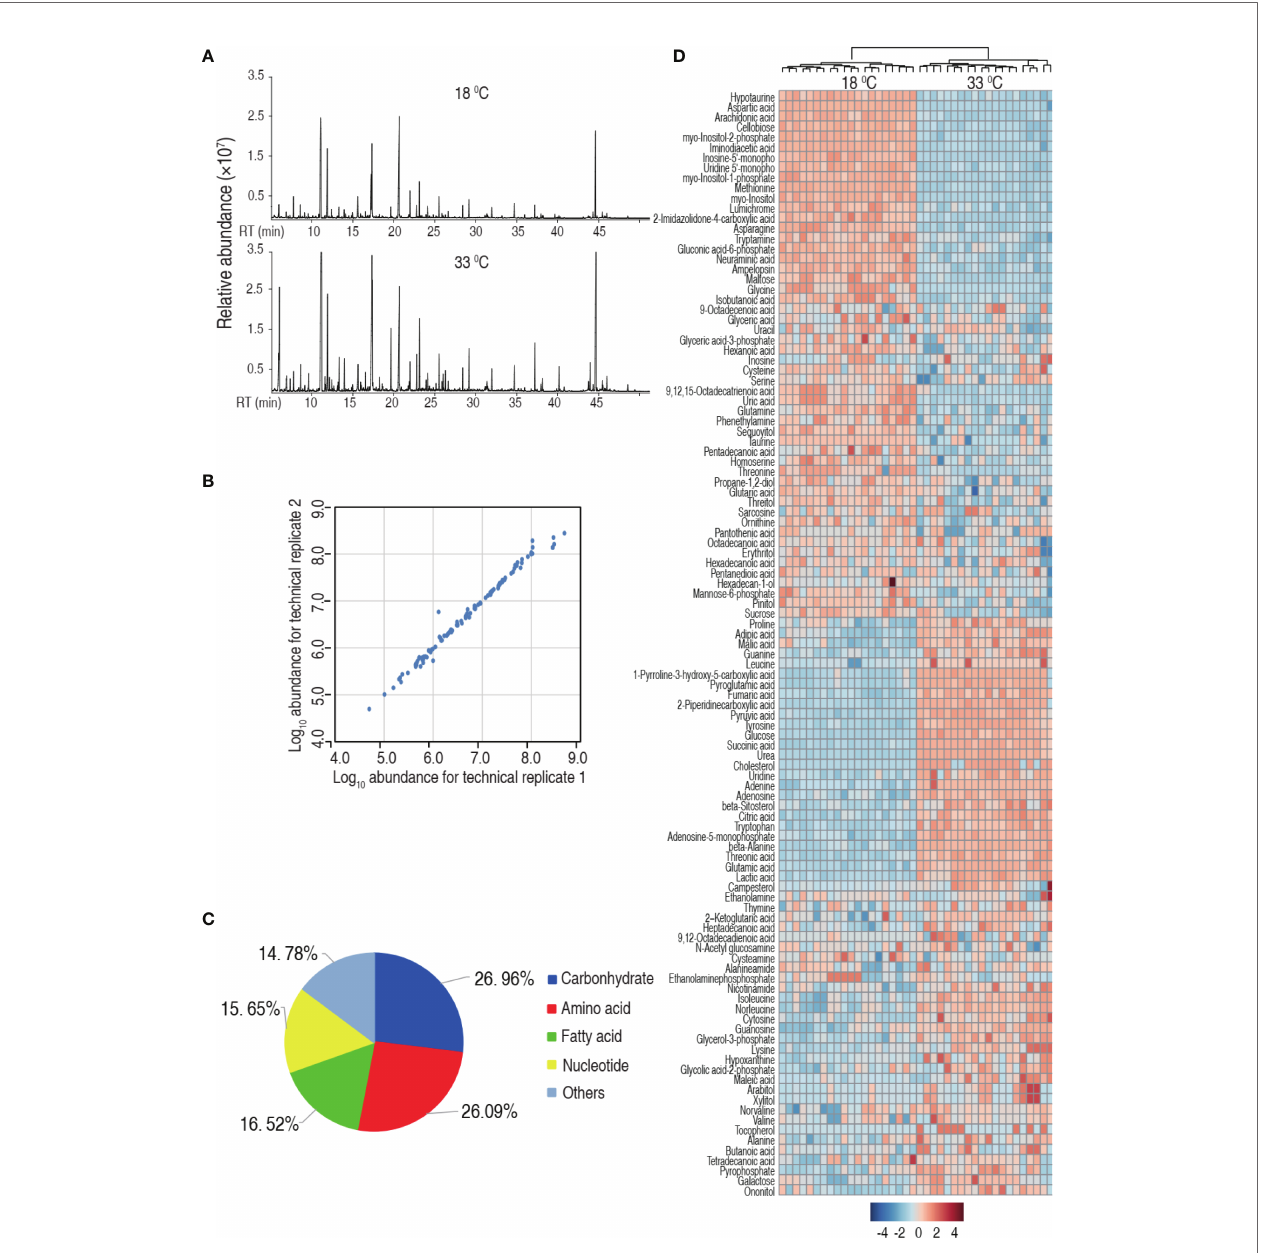
FIGURE 2 | Tilapia cultured at 18°C or 33°C had a different metabolome. (A) Representative total ion current chromatogram from 18°C or 33°C of samples. (B) Reproducibility of the metabolomic pro fi ling platform used in the discovery phase. Abundance of metabolites quanti fi ed in samples over two technical replicates is shown. The Pearson correlation coef fi cient between technical replicates varies between 0.9307 and 0.9996. (C) Categories of the differential metabolites. One hundred fi fteen metabolites with differential abundance are searched against in KEGG for their categories, and the pie chart is generated in Excel 2010 (Microsoft, USA). (D) Heat map of unsupervised hierarchical clustering of different metabolites (row). Blue and red indicate decrease and increase of the metabolites scaled to mean and standard deviation of row metabolite level, respectively (see color